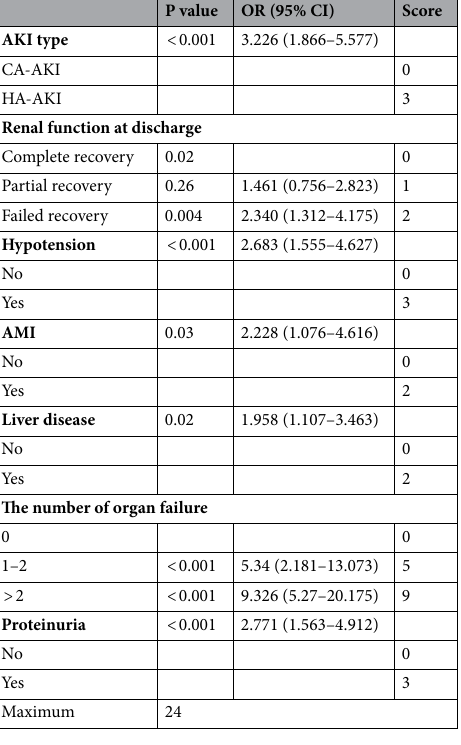
Table 1. Seven-variable risk index for affecting 30-day mortality in the hospitalized elderly patients with AKI. AKI acute kidney injury, CA-AKI community acquired AKI, HA-AKI hospital acquired AKI, AMI acute myocardial infarction, CI confidence interval, OR odds